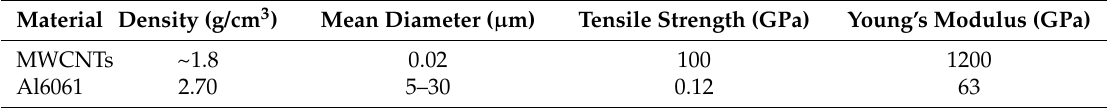
Table 1. Properties of multi-walled carbon nanotubes (MWCNTs) and Al6061